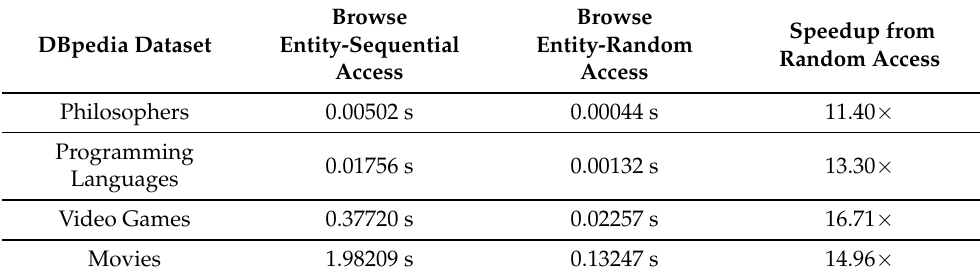
Table 4. Average execution time (in seconds) for retrieving the desired data for an entity and for creating its default similarity graph.